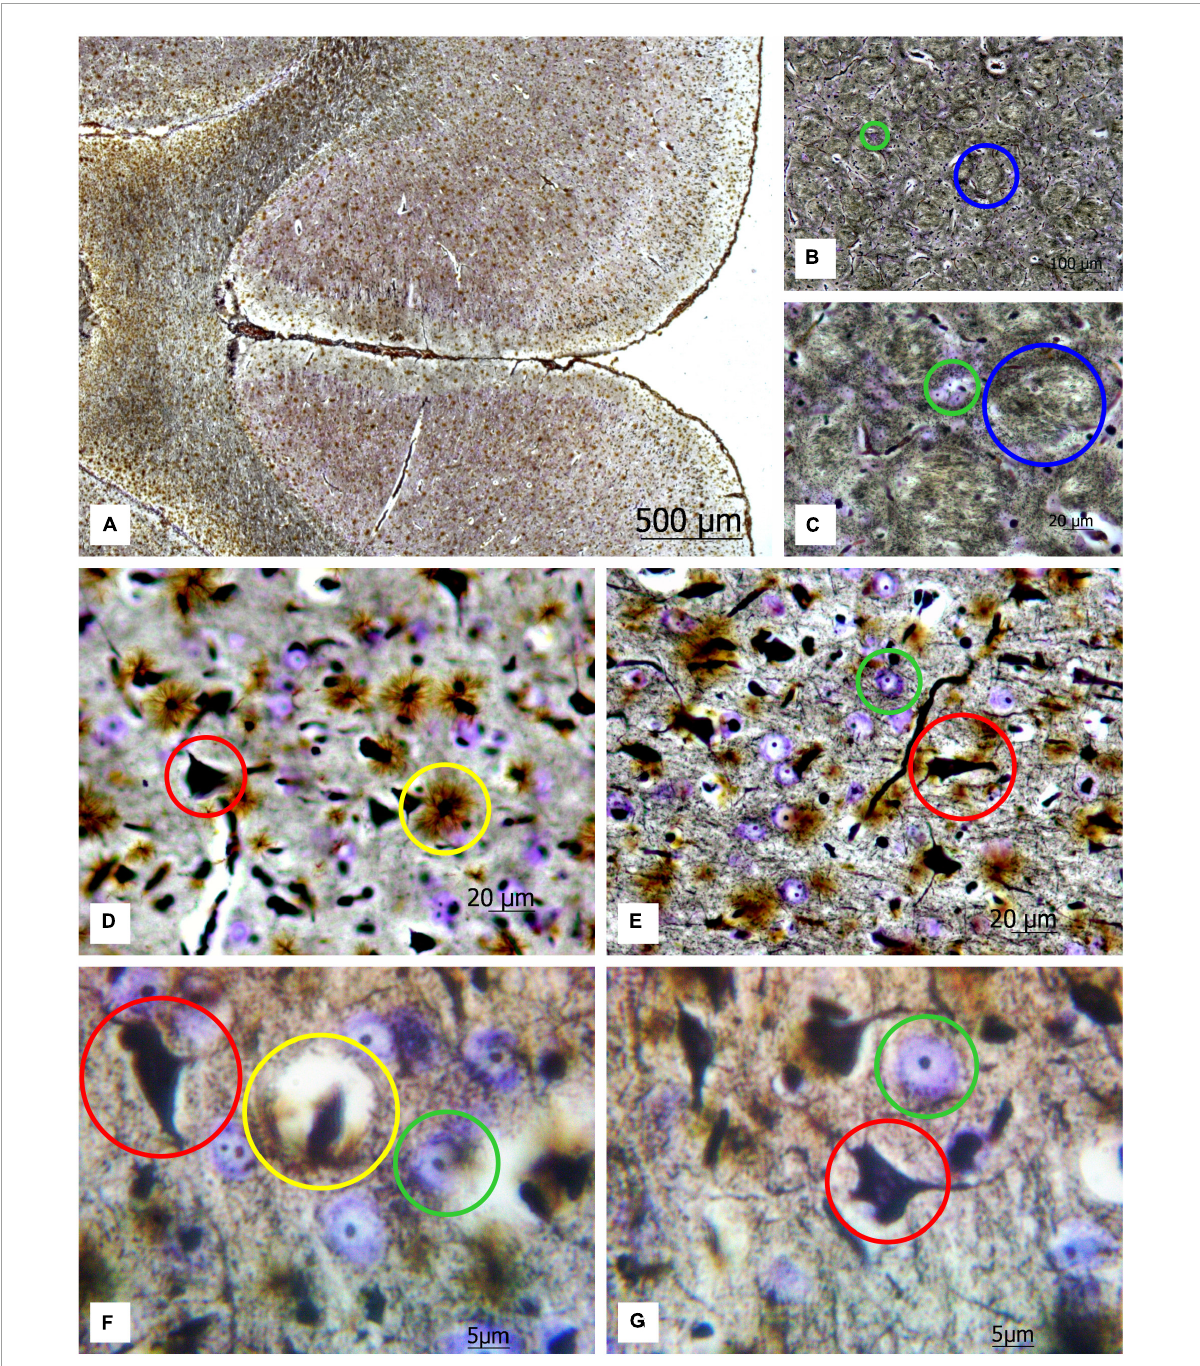
FIGURE2 (A) Image of a rat brain after combined staining. Ob. 2.5x, oc. 20x; (B) transversely oriented nerve fibers (blue circles) and (C) neurons stained by the Nissl method (green circles) highlighted in the image of the rat striatum. Ob. 40x, oc. 20x; (D) protoplasmic astrocytes (yellow circles), impregnated neurons (red circles); (E) neurons stained with cresyl violet (green circles) highlighted in the image of the rat motor cortex. Ob. 40x, oc. 20x. (F,G) protoplasmic astrocytes (yellow circle), impregnated neurons (red circle), and neurons stained with cresyl violet (green circle) highlighted in the image of rat motor cortex. Ob. 100x, oc.